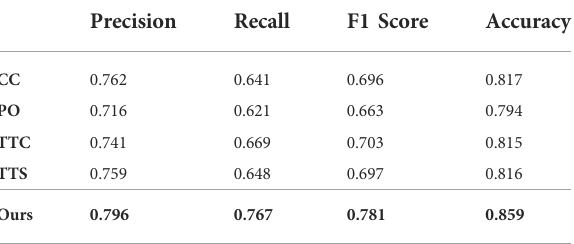
TABLE 2 Performance comparison with